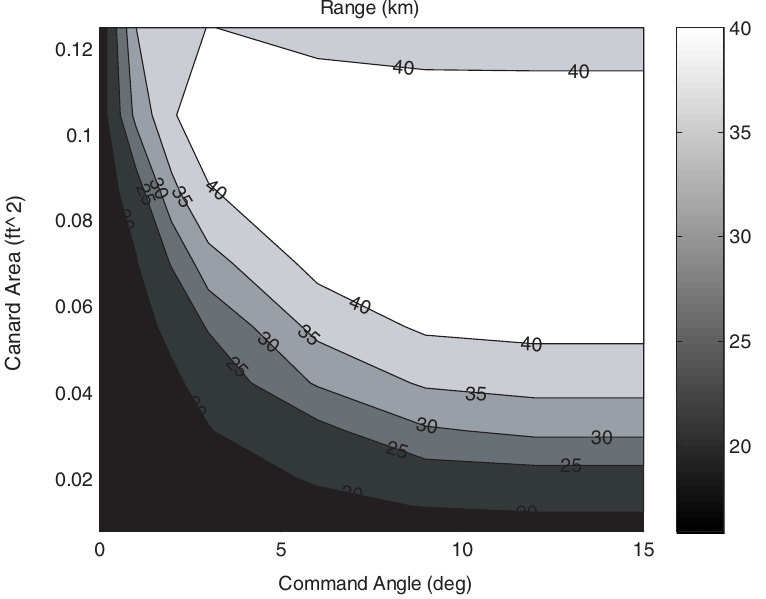
Fig. 12. Range vs. canard area and canard command